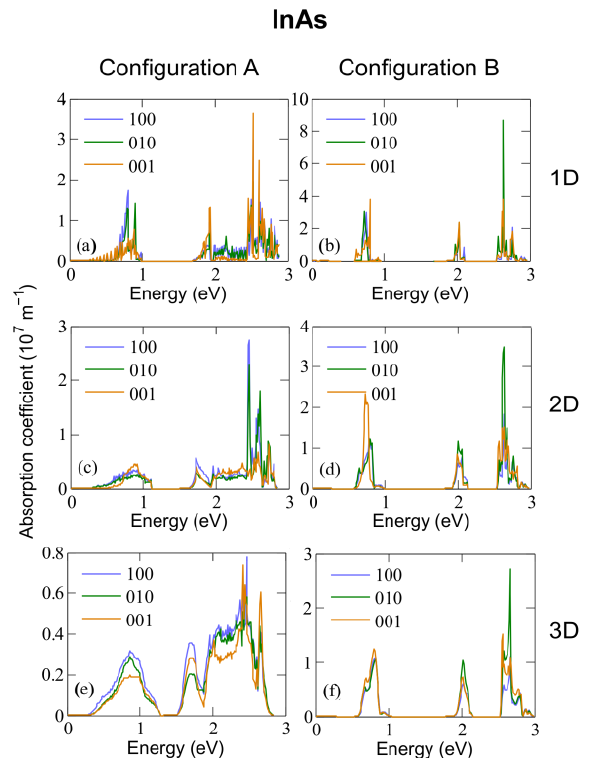
Figure 6. Absorption coefficient calculated at 300 K for 1D ( a , b ), 2D ( c , d ) and 3D ( e , f ) arrays of InAs dots with radius R = 12.2 Å and either anion-rich (configuration A, left panels) or cation-rich (configuration B, right panels)